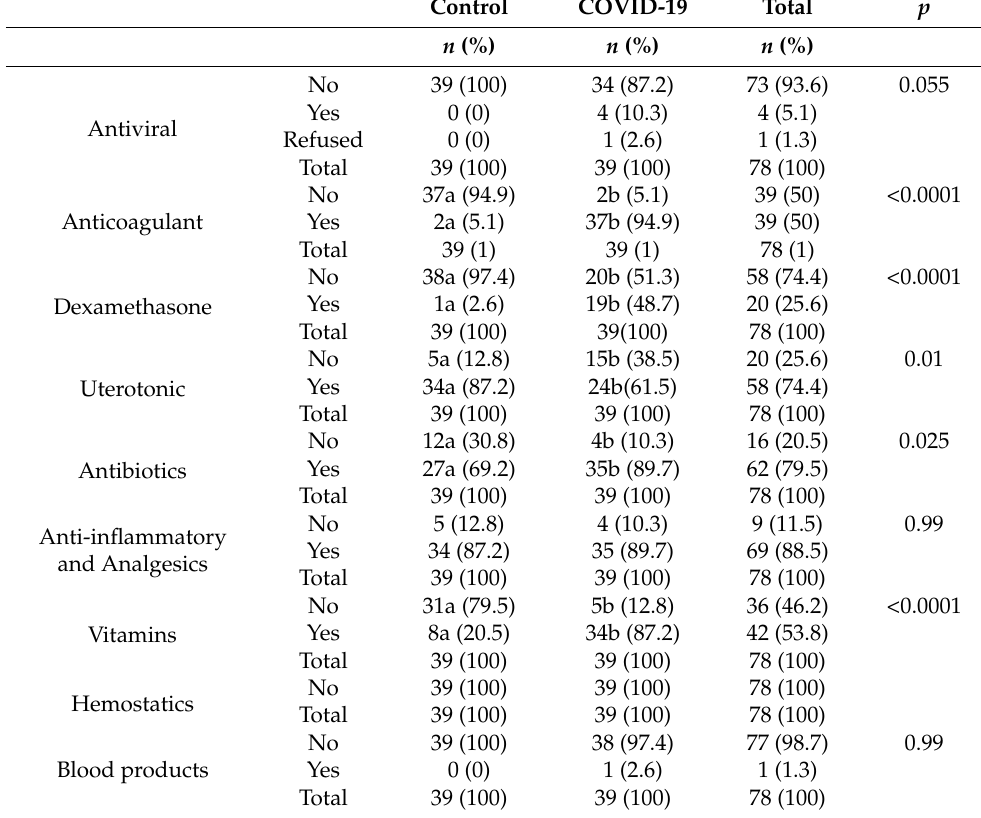
Table 3. Comparison of the variables according to COVID 19- positive and control